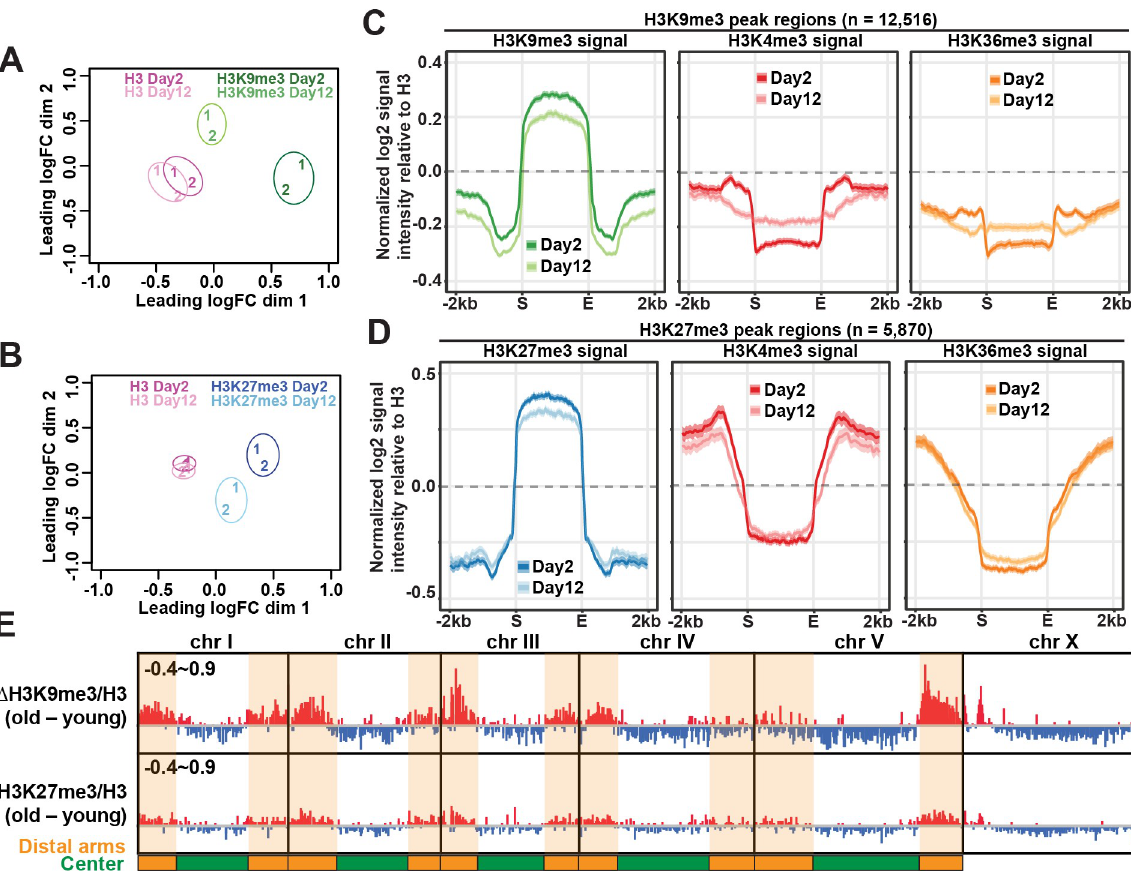
Fig 1. Region-specific gain and loss of repressive marks in aged somatic tissues. Multidimensional scaling (MDS) plots showing the similarity between ChIP-seq replicates of H3 controls (A & B), H3K9me3 (A), and H3K27me3 (B) in young (day 2 adults) and old (day 12 adults) worms. Two biological replicates are represented by numbers (1 and 2). There were age-dependent changes in H3K9me3 and H3K27me3 but not H3 controls. (C) Metaplots showing the average z-scores of H3K9me3, H3K4me3 and H3K36me3 ChIP-seq signal intensity normalized to H3 (log 2 ) across H3K9me3 peak regions ( ± 2kb flanking regions; n = 12,516). The average H3K9me3 enrichment across all peaks was reduced with age. The sharp decline of H3K4me3 and H3K36me3 at the boundaries of H3K9me3 peaks was concomitantly lessened with age. (D) Metaplots showing the average z-scores of H3K27me3, H3K4me3 and H3K36me3 ChIP-seq signal intensity normalized to H3 (log 2 ) across H3K27me3 peak regions ( ± 2kb flanking regions; n = 5,870). The average H3K27me3 enrichment across all peaks was reduced with age. (C-D) The solid lines represent the average z-scores with shaded areas showing the 95% confidence intervals. (E) IGV browser view showing age-dependent changes (old–young) in the average z-scores of normalized H3K9me3 and H3K27me3 signal intensity along the entire genome in 20-bp bins. Red and blue bars indicate an increase and decrease, respectively, in the average z-scores. The numbers on the top left corner of each track indicate the y- axis range. Distal arms of autosomes are highlighted by the orange shaded regions, and central regions are shaded green.